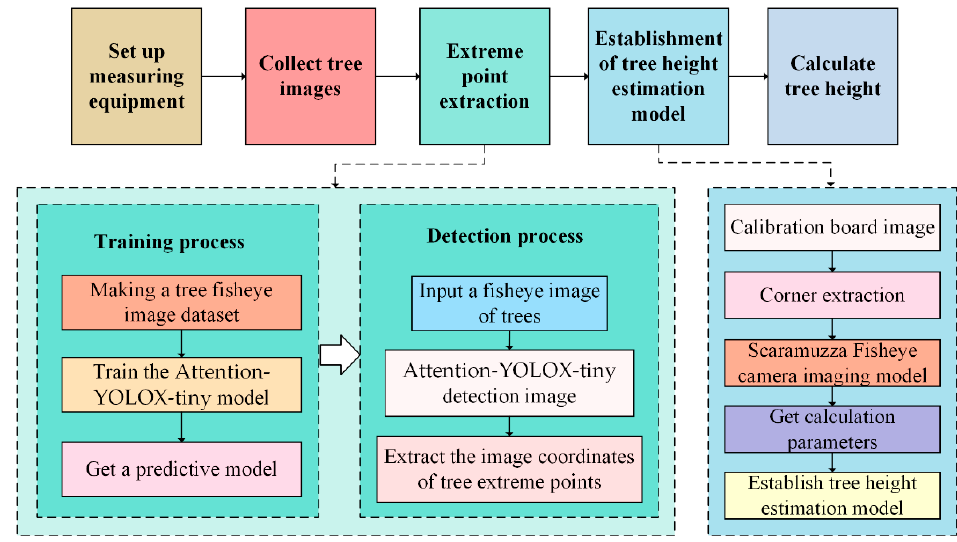
Figure 2. Tree height calculation process.